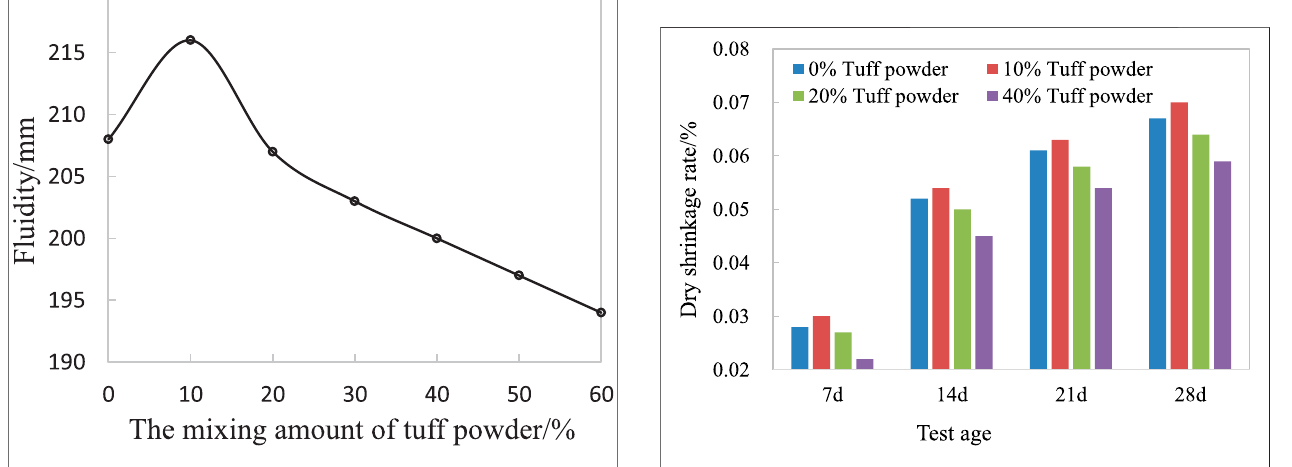
FIGURE 3 | The test results of fl uidity of tuff powder-cement mortar. FIGURE 4 | The dry shrinkage rates of tuff powder-cement